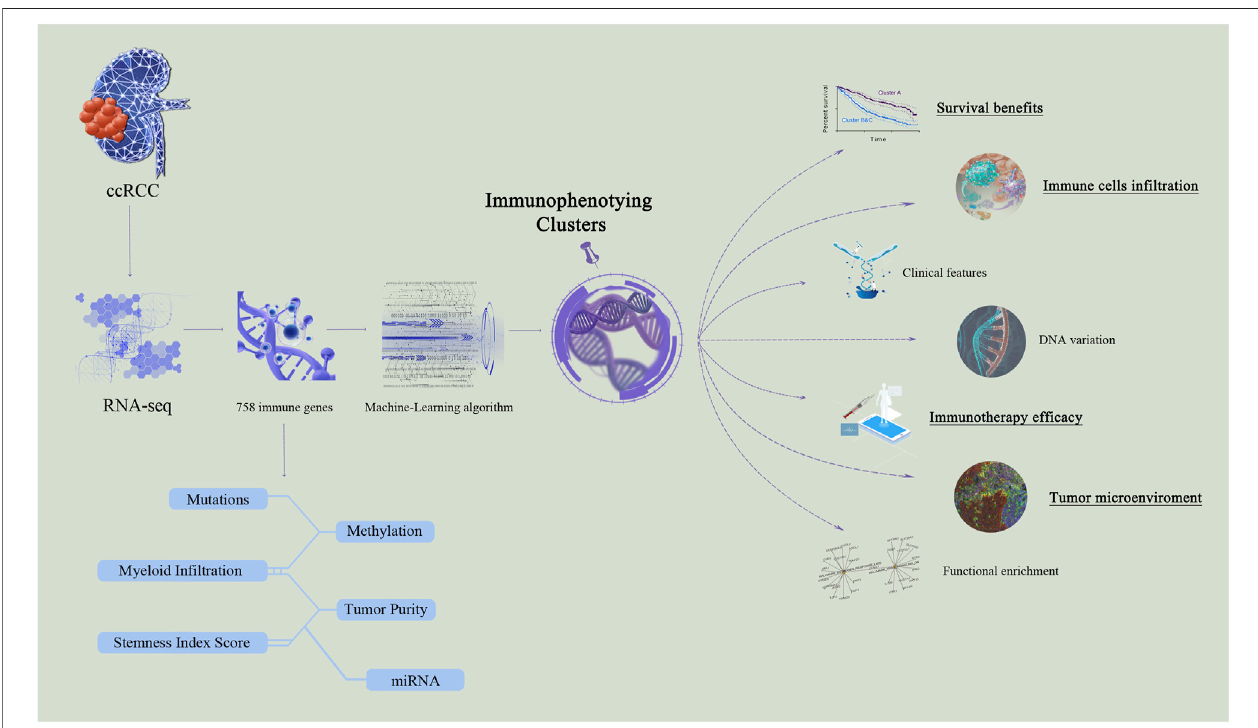
FIGURE 1 | Computational and experimental work fl ow for immunophenotyping clusters.